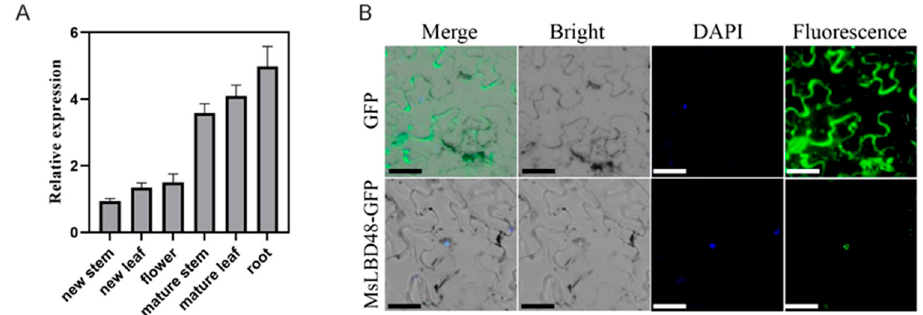
Figure 8. The expression profile of MsLBD48 . ( A ). Expression analysis of MsLBD48 in alfalfa tissues using qRT-PCR. Bars represented ±SD of three biological replicates. ( B ). Subcellular localization analysis of 35S::MsLBD48 -GFP in epidermal cells of tobacco leaves transiently expressing the contract. Bar = 200 µm.